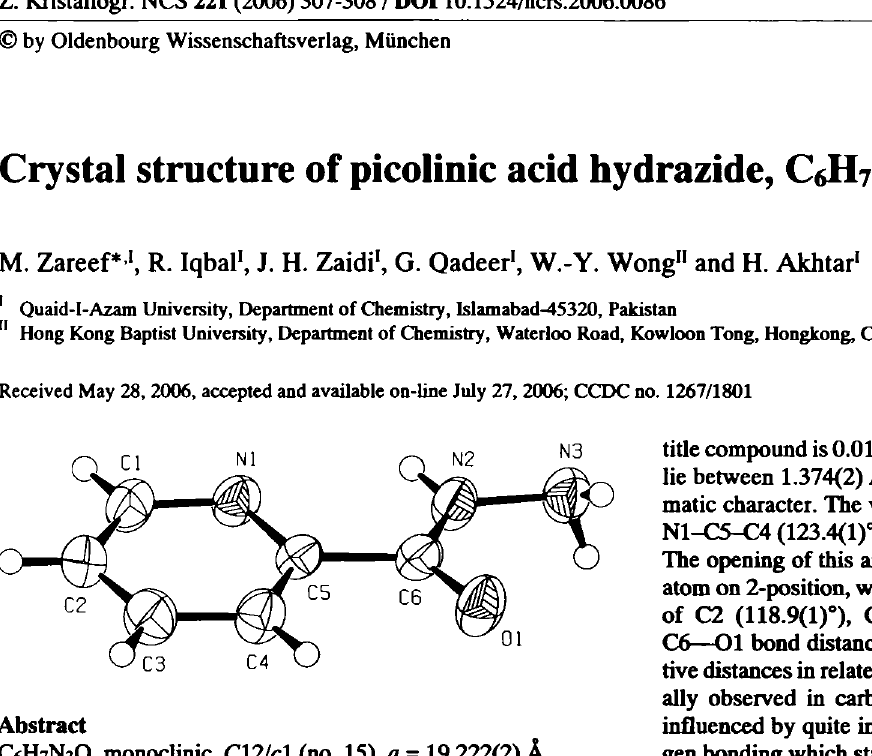
Table 1. Data collection and handling.